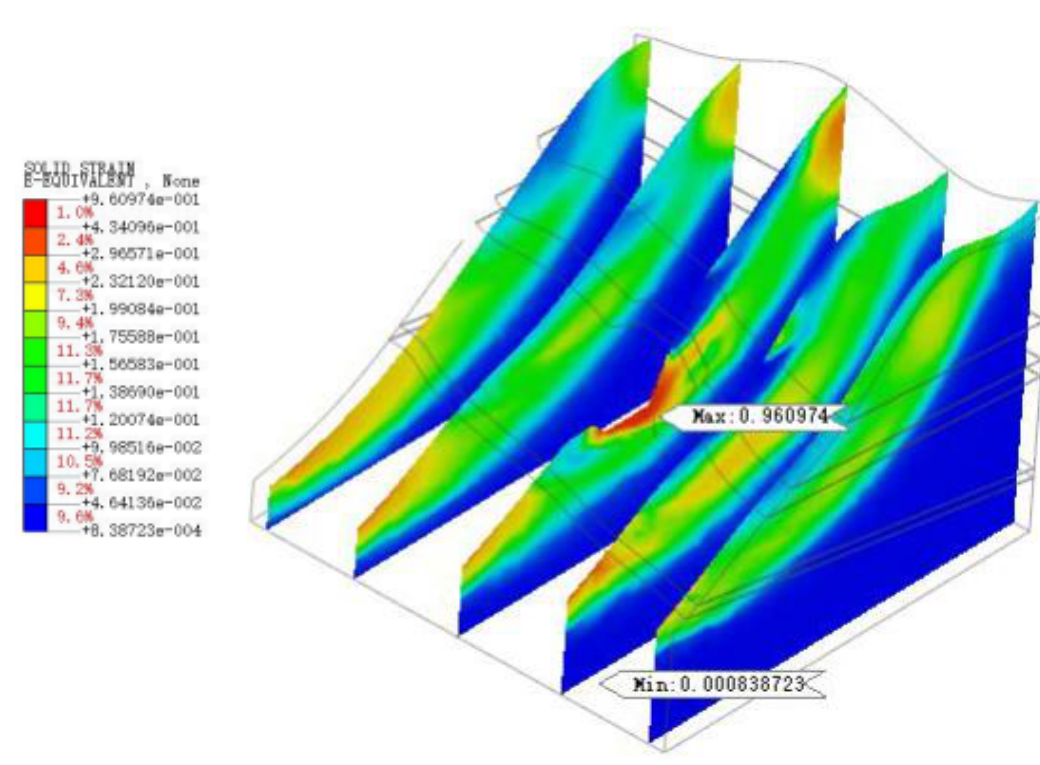
Figure 24. The maximum shear stress of slope.